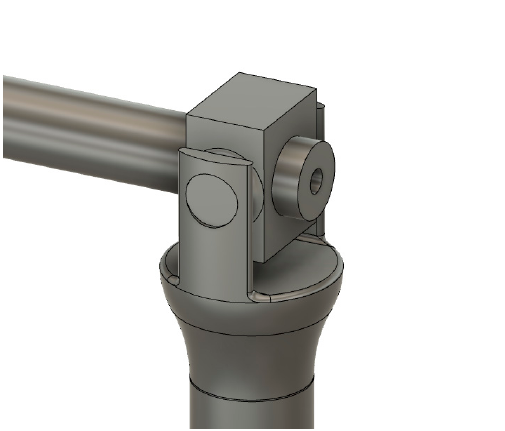
Figure 5. Joint parts of analytical